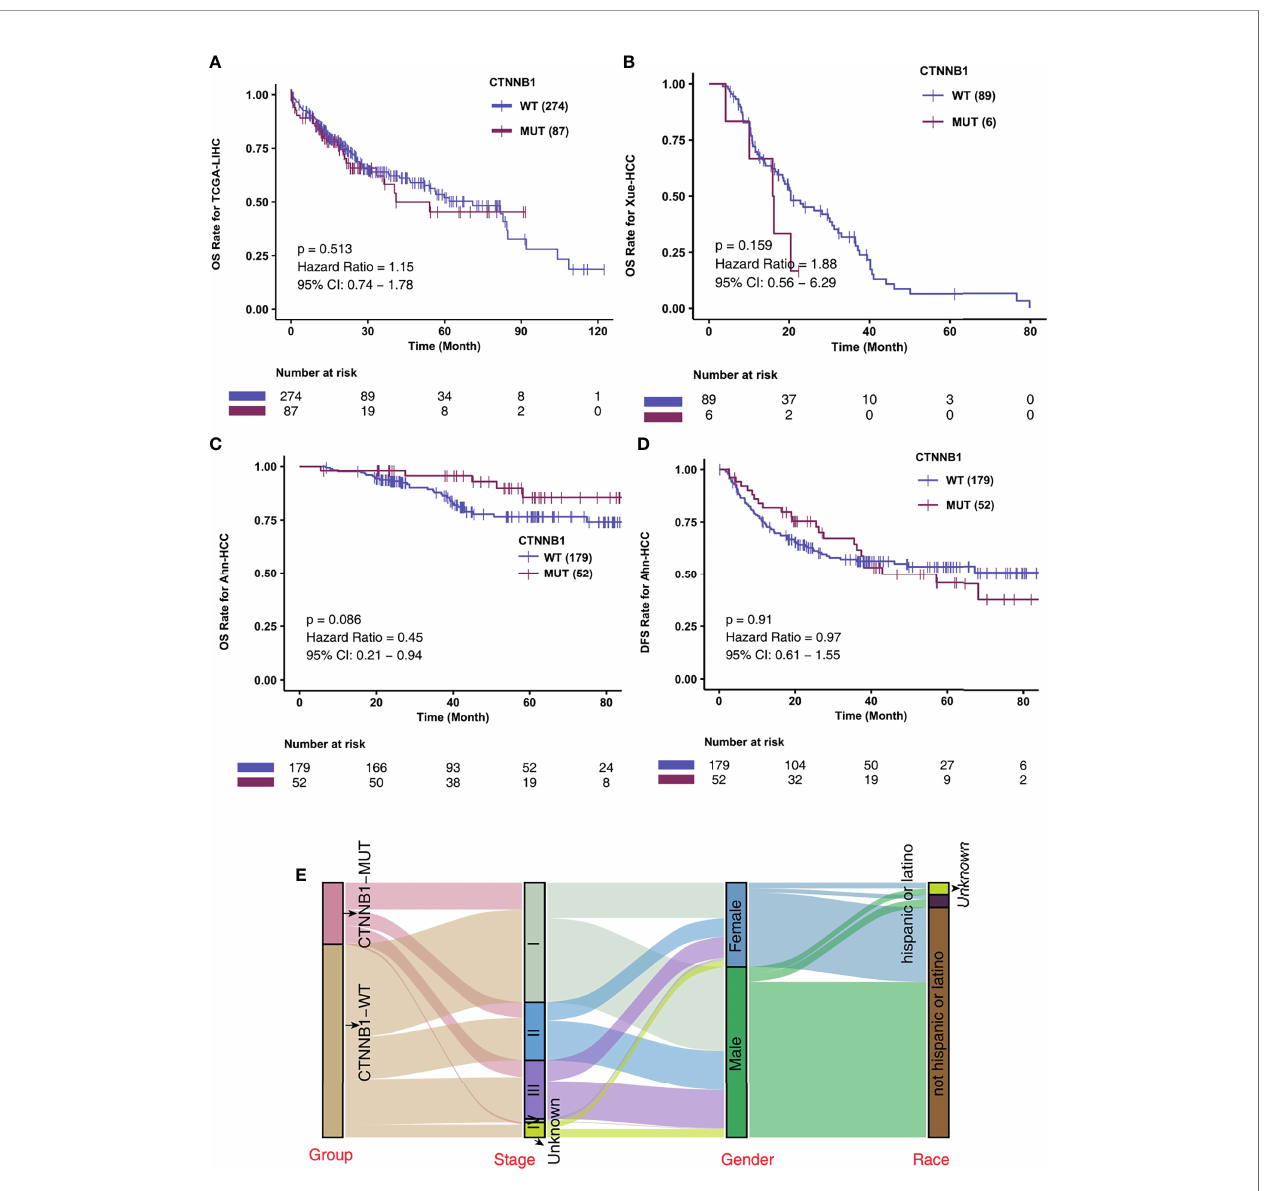
FIGURE 3 | CTNNB1-MUT was not associated with prognosis in HCC patients responding to routine treatment. Kaplan-Meier curves comparing the overall survival (OS) of patients with CTNNB1-Mutant (CTNNB1-MUT) and patients with CTNNB1-wildtype (CTNNB1-WT) in the TCGA-LIHC (A) , Xue-HCC (B) and Ahn-HCC (C) cohorts. (D) Kaplan-Meier curves comparing the disease-free survival (DFS) of patients with CTNNB1-Mutant (CTNNB1-MUT) and patients with CTNNB1-wildtype (CTNNB1-WT) in the Ahn-HCC cohort. (E) A Sankey diagram visualizing the clinical characteristics between CTNNB1-MUT and CTNNB1-WT patients in the TCGA- LIHC